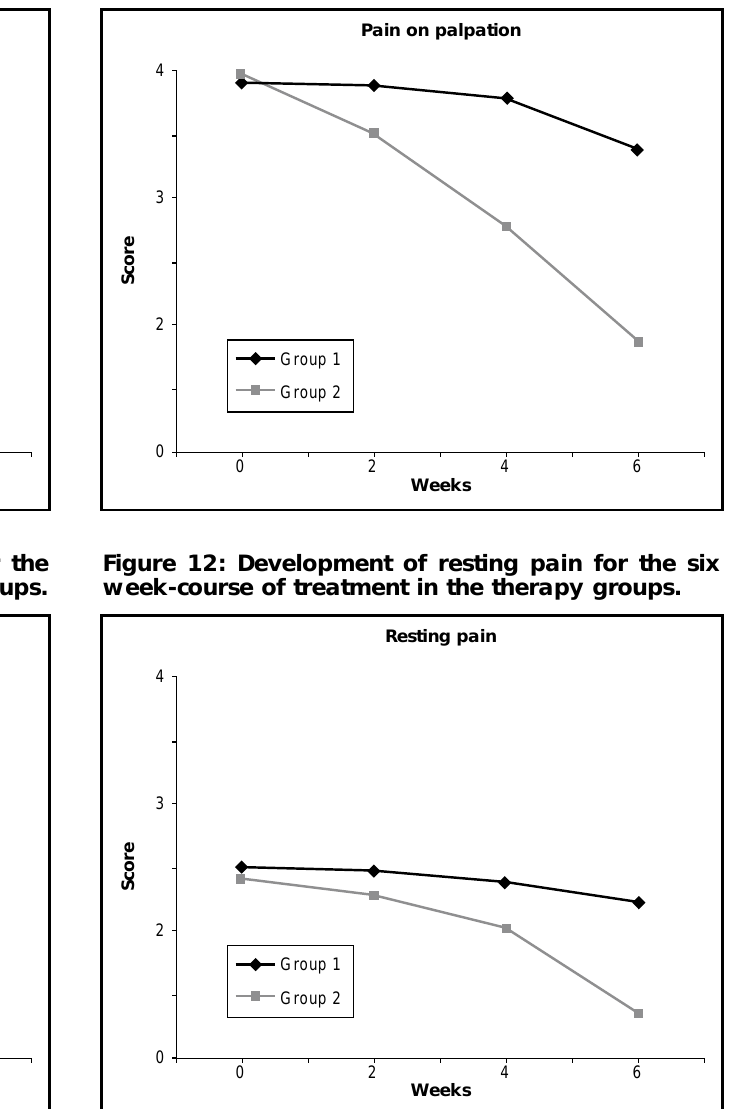
Figure 9: Development of pain on weight bearing for the six week-course of treatment in the therapy groups.